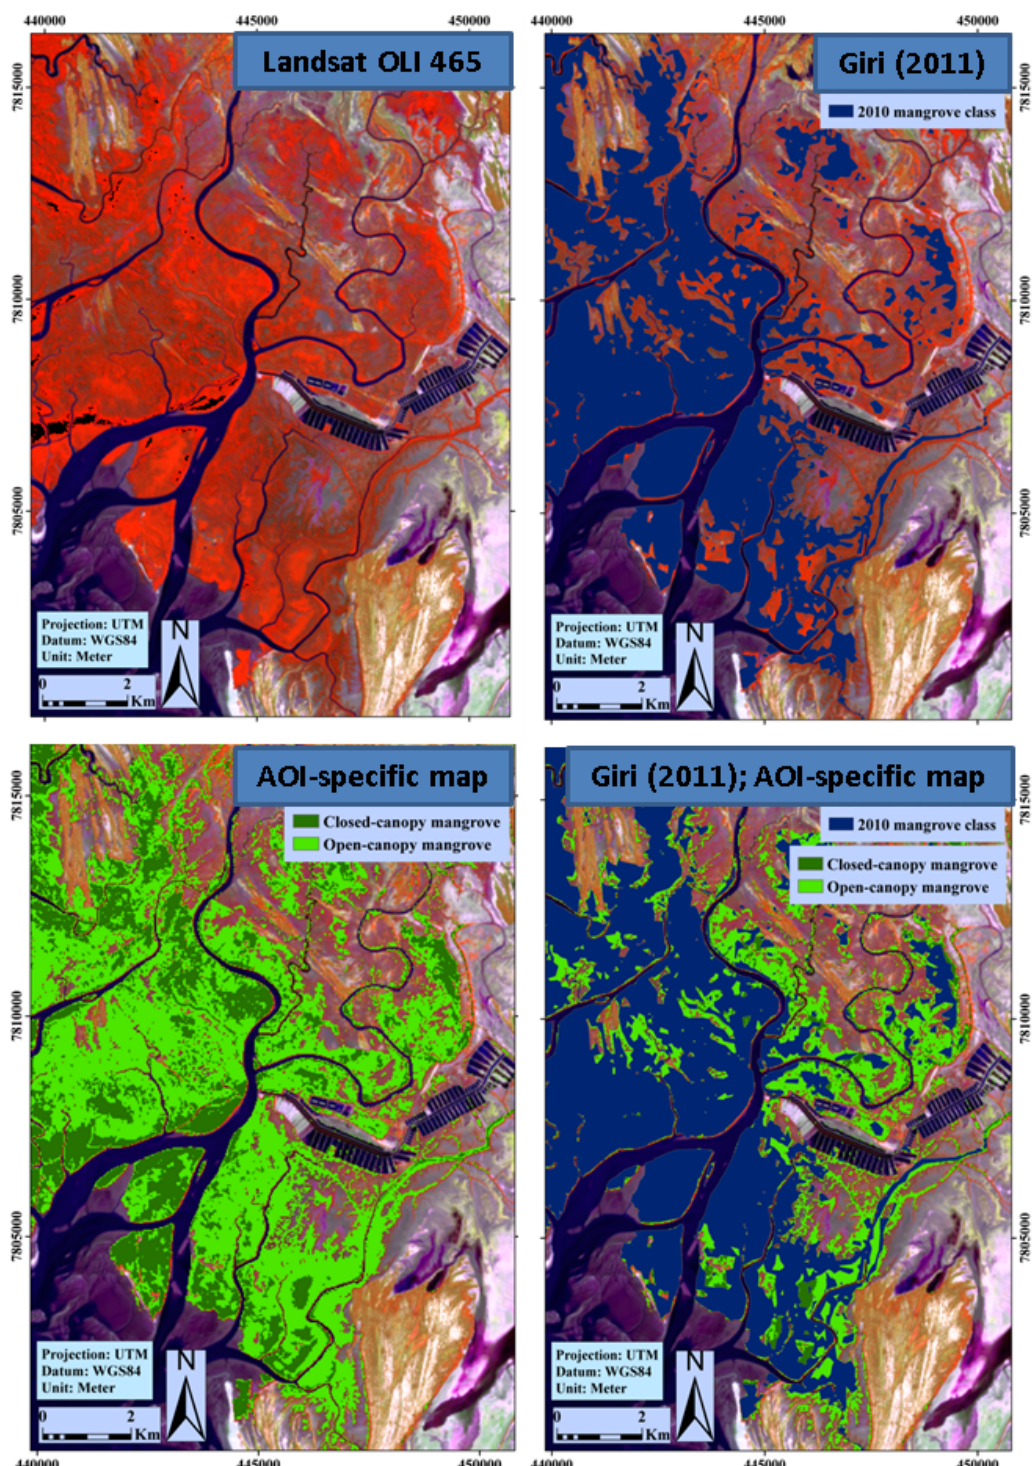
Figure 8. A Landsat OLI 465 false color composite from July, 2014, over the Tsiribihina-Manambolo Delta (TMD) AOI, is shown in the top left panel, wherein mangroves appear primarily in shades of red. The other panels compare USGS-produced national-level mangrove coverage circa 2010 (Giri [69]) to one of the detailed, contemporary, AOI-specific maps produced through this study. The comparison demonstrates how the USGS map (Giri [69]) underrepresents naturally lower stature, more open or highly degraded mangroves and at times omits scrub/shrub and narrow linear strips of mangroves.